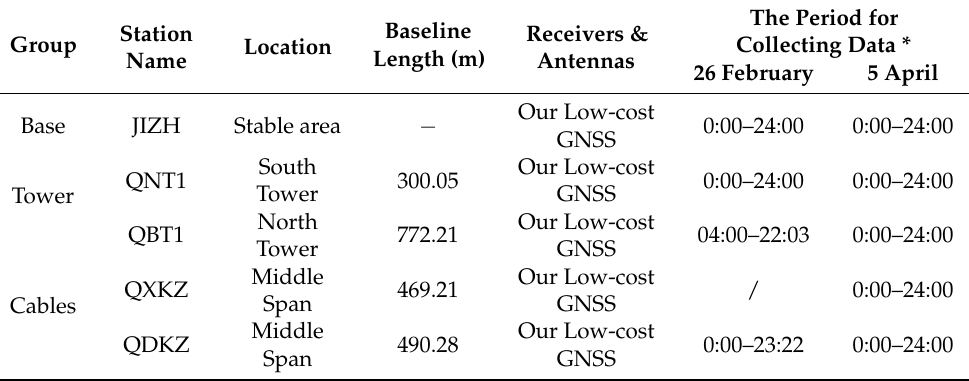
Table 4. Specifications of low-cost GNSS stations for the Guojiatuo Suspension